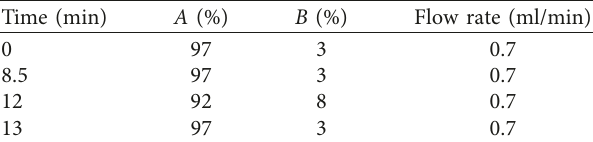
Table 1: Final gradient program for HPLC sample